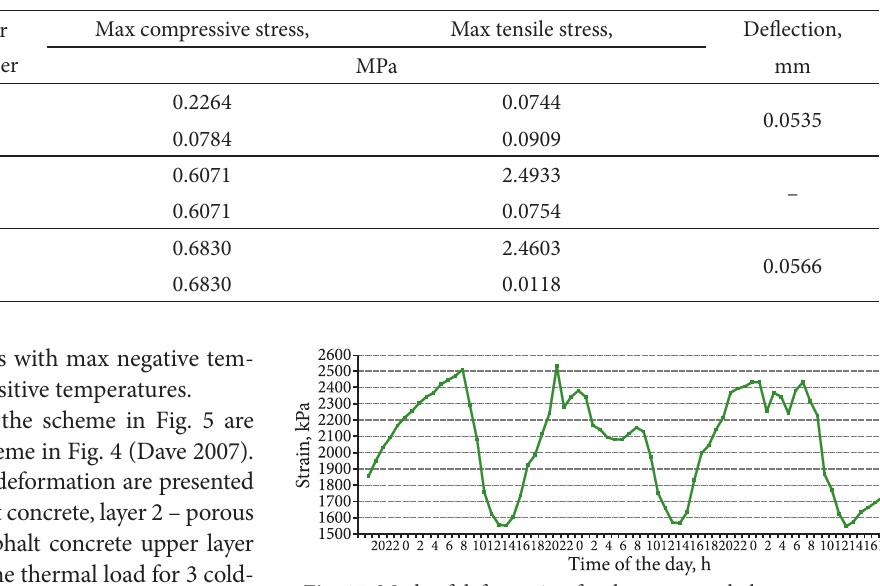
Fig. 17. Mode of deformation for the upper asphalt concrete layer – stresses during the days with max negative temperatures (scheme in Fig. 4)